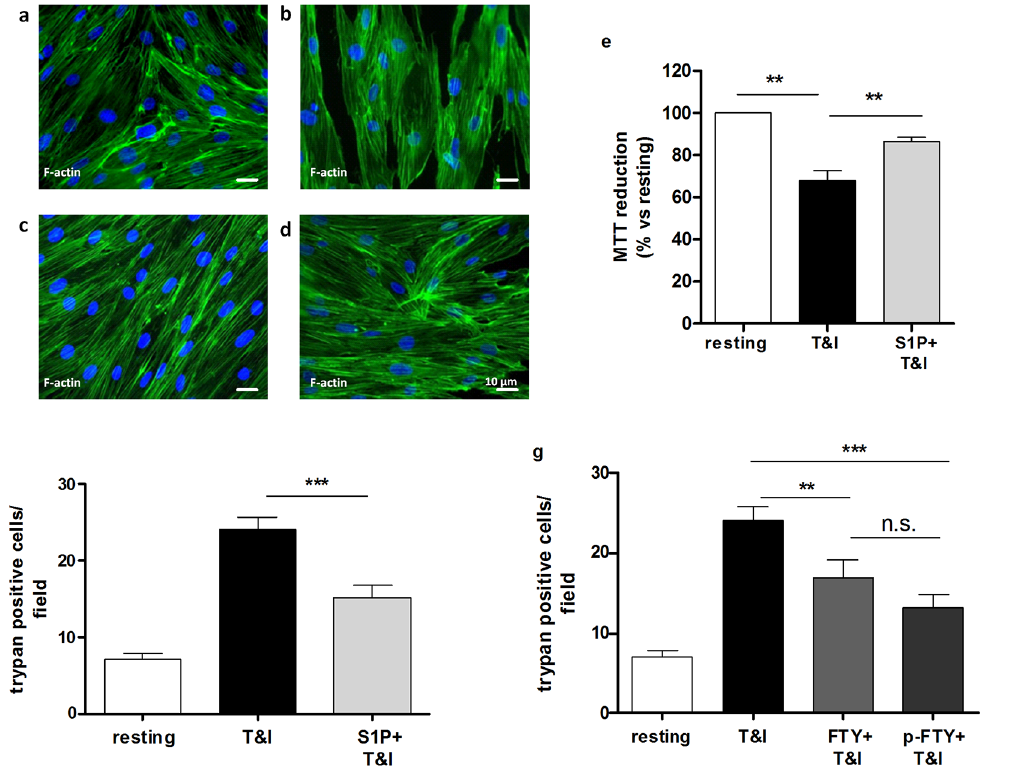
Fig 1. Exposure to T&I and S1P receptor modulators modifies hBMVEC morphology and viability. a . Immunostaining for the cytoskeleton component F-actin, shows a confluent monolayer characterized by fusiform morphology and strict cell-to-cell contacts. b . Exposure to inflammatory cytokines, TNF α (10 U/ml) and IFN γ (5 U/ml) (T&I), causes changes in hBMVEC morphology as consequence of reduced cell viability. In the presence of S1P (50 nM, c ) or fingolimod phosphate (pFTY 50 nM, d ), effects of T&I on hBMVEC morphology are lessened. Scale bar represent 10 μ M. e . hBMVEC ability to metabolize MTT is reduced as consequence of exposure to T&I for 24 h, while in the presence of S1P (50 nM), this effect is reverted. Values represent absorbance at 570 nm, normalized to resting conditions, in which hBMVEC are considered maximally viable. Data are mean ± S.E.M. of four independent experiments, each run in triplicate. ** p < 0.01 vs. T&I, *** p < 0.001 vs. T&I. f . Trypan blue exclusion demonstrates increased hBMVEC death after 24 h exposure to T&I. S1P (50 nM) co-treatment is conversely able to reduce this effect. g . Exposure to T&I in the presence of either FTY (50 nM) or pFTY (50 nM), shows a reduction in hBMVEC death. Data are mean ± S.E.M. of four independent experiments, each run in triplicate, in which three to five fields per well were counted. ** p < 0.01 vs T&I, *** p < 0.001 vs